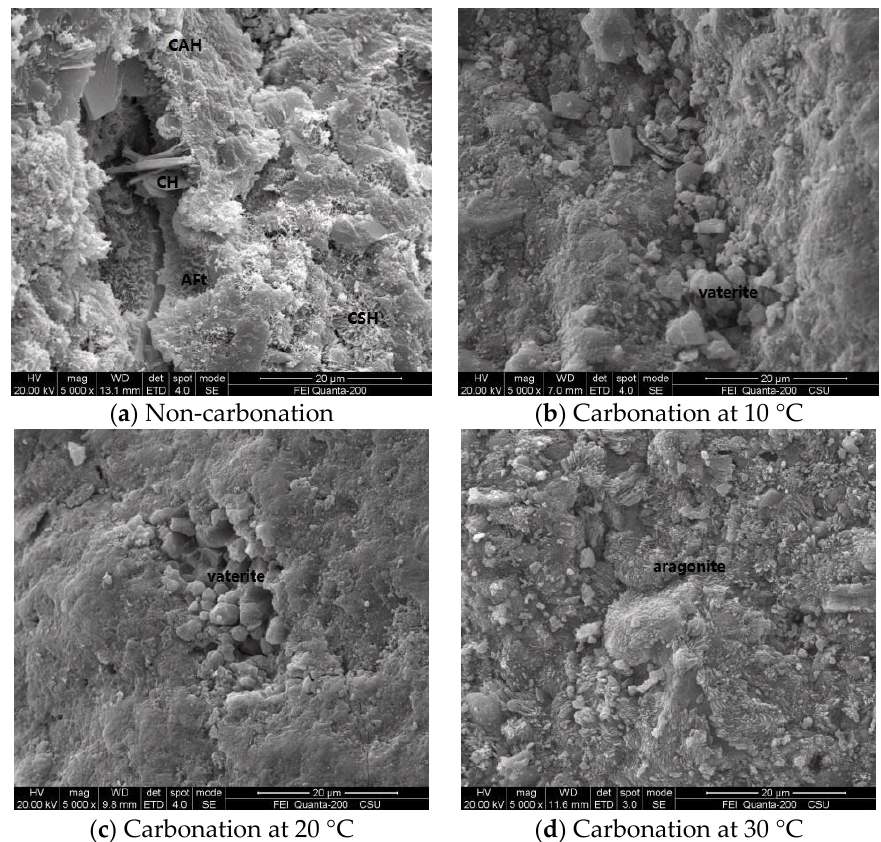
Figure 8. ESEM spectra of carbonation specimens under different temperatures.